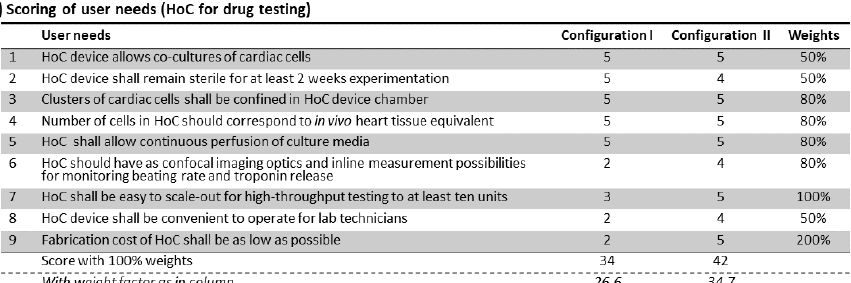
Figure 9. ( A ) Functional components required for a design of a MBR with cardiac cells based on the functional subsystems in Figure 7. ( B ) Two possible configurations of these functional components. ( C ) A comparison of the two configurations with the user needs in Table 4 in which scores are calculated for weight factors (all of which are 100%) or as shown in last column in the table.